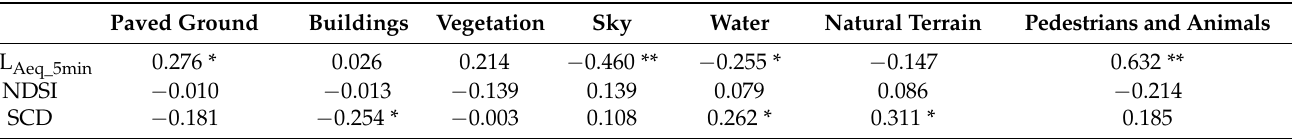
Table 8. Spearman’s rho correlation coefficients for the relationship between seven visual elements and soundscape evaluation